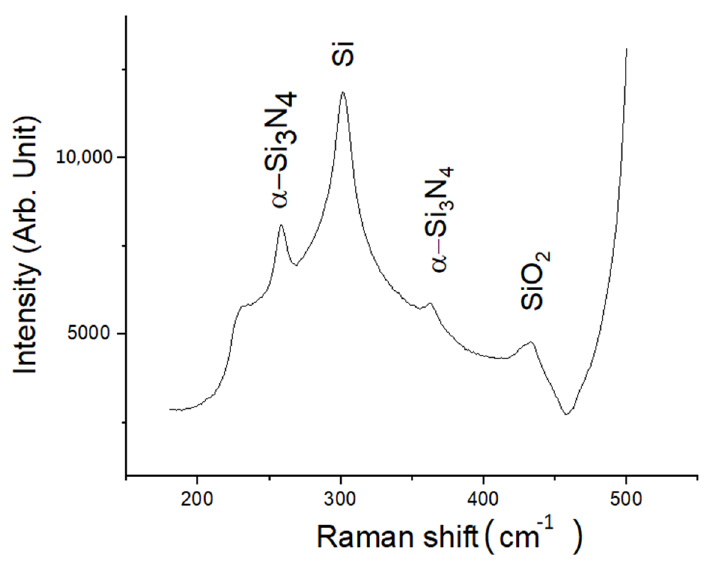
Figure 2. Raman spectrum of a nitrided substrate of SiO 2 /Si after nitriding for 20